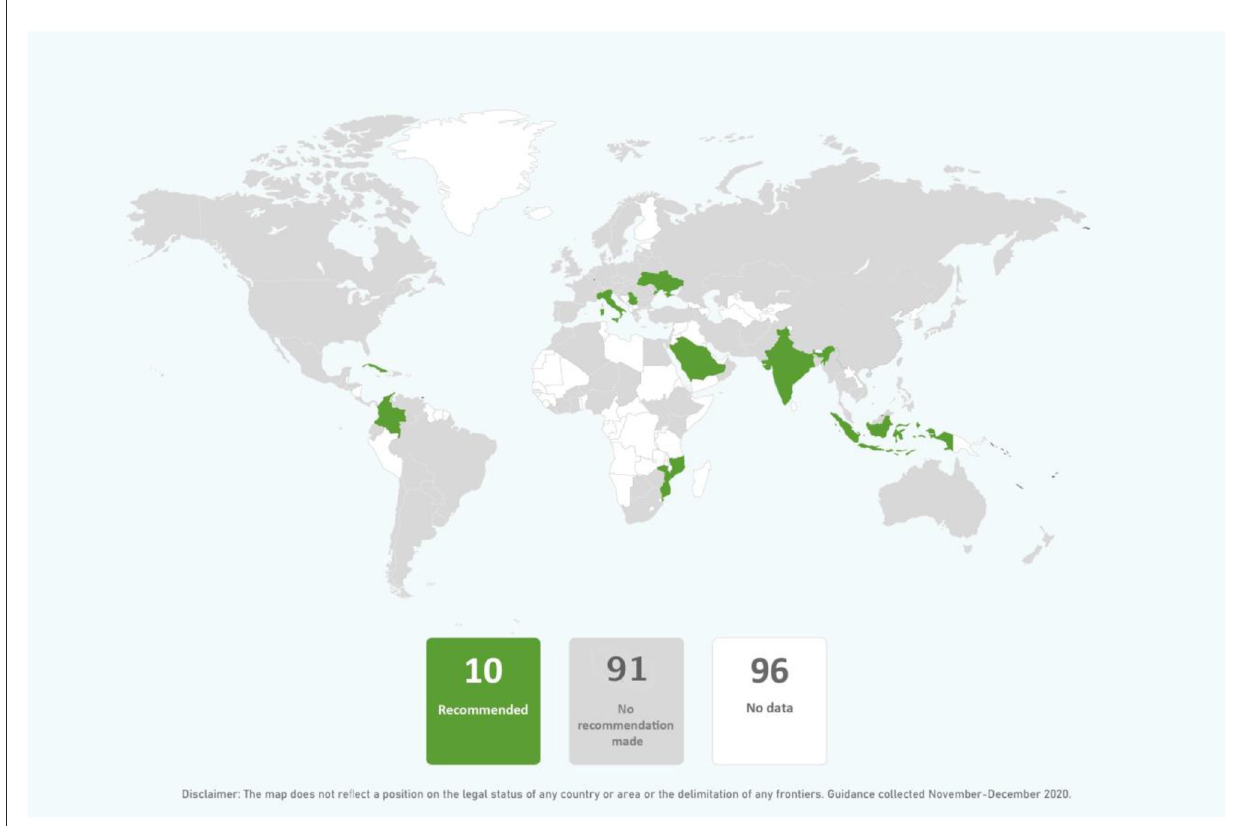
FIGURE6 Global distribution of recommendations on relactation support for mothers with COVID-19 (data from 101 countries).